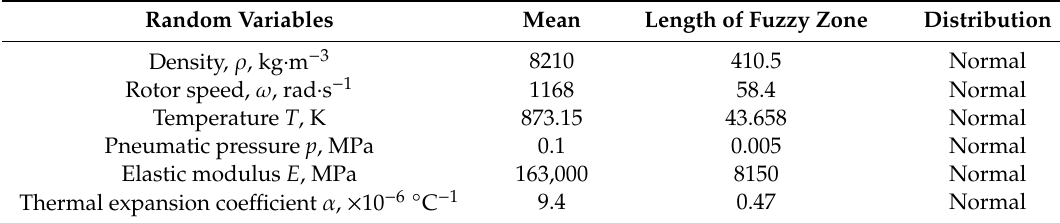
Table 1. Distribution characteristics of input random variables.